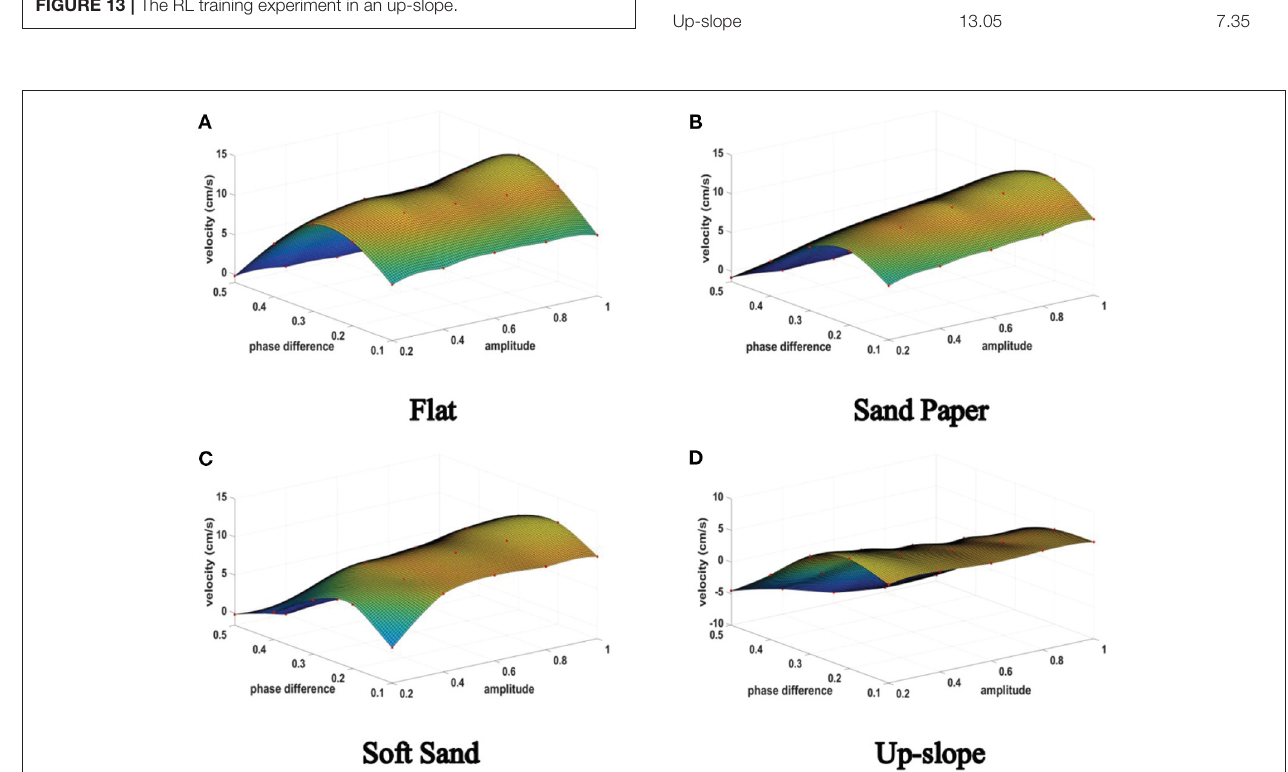
FIGURE 14 | The hexapod robot velocity in different